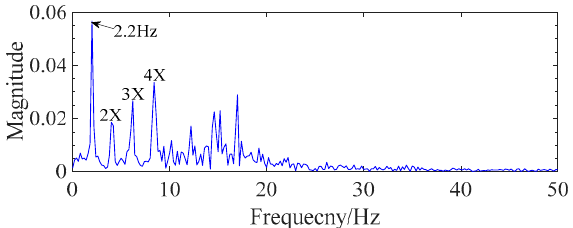
Figure 15. Feature-frequency extraction of gear-scuffing fault.